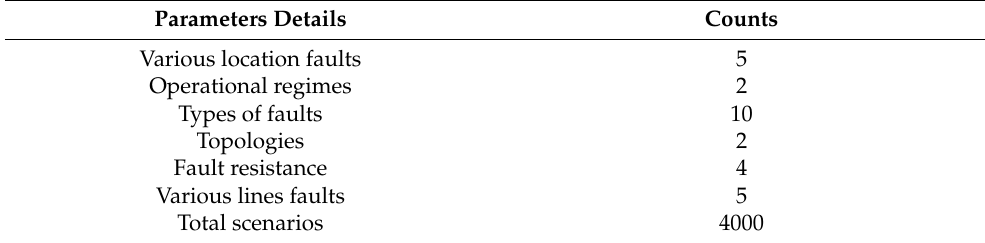
Table 1. Fault cases simulation conditions.